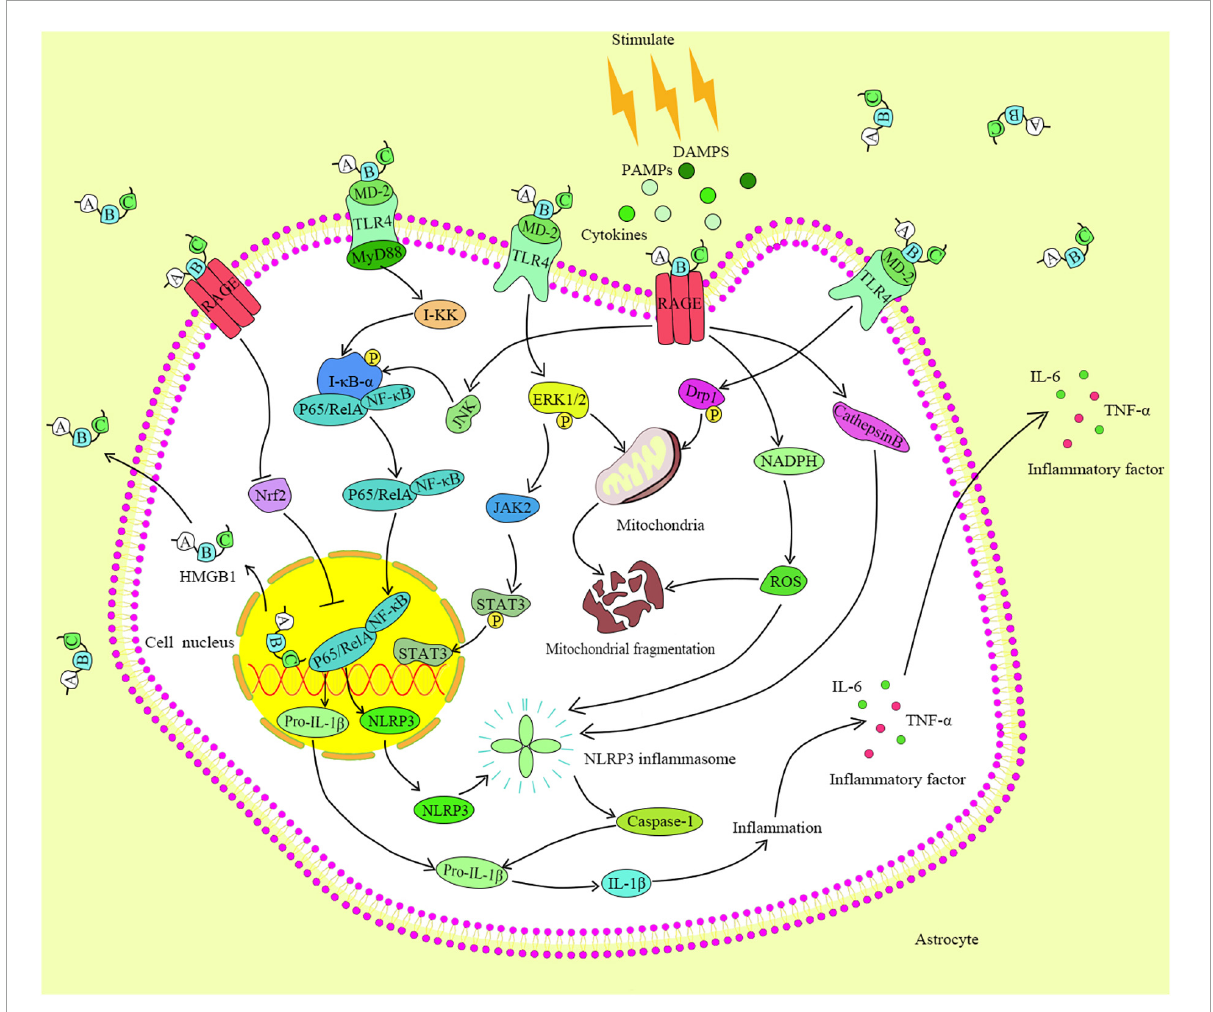
FIGURE2 HMGB1 identification and its binding are by different receptors on the cell membrane. The pairing of TLR4 with HMGB1 activates the MyD88, which in turn activates the I- κ B kinase and NF- κ B pathway, and triggers the expressions of downstream factors.